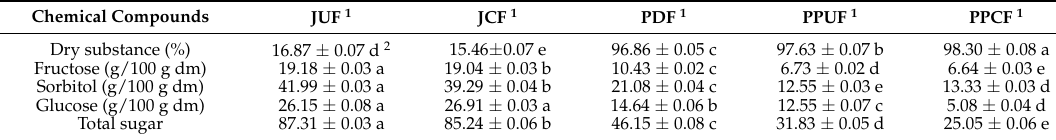
Table 1. Chemical composition of samples from black